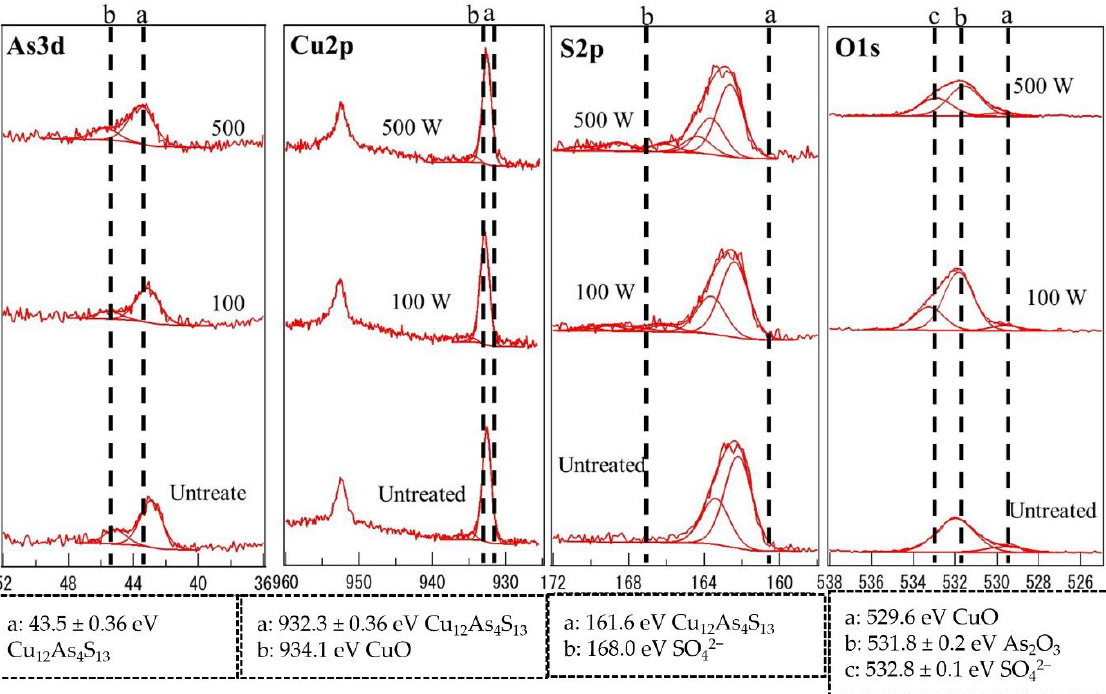
Figure 4. XPS spectra of tennantite before and after microwave treatment for 60 s.